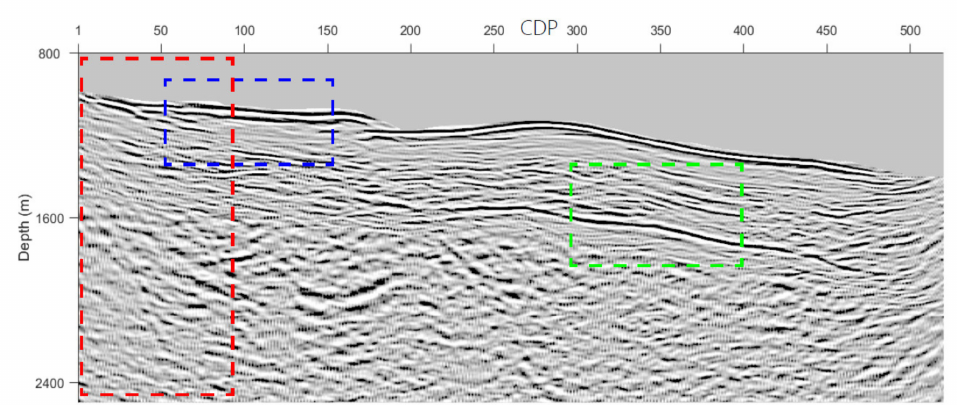
Figure 5. Imaging section calculated by multiple waves. The blue and green dashed boxes indicate the blow-up reported in Figures 6 and 7 respectively. The red dashed box underlines that the boarder effects of the migration are limited.